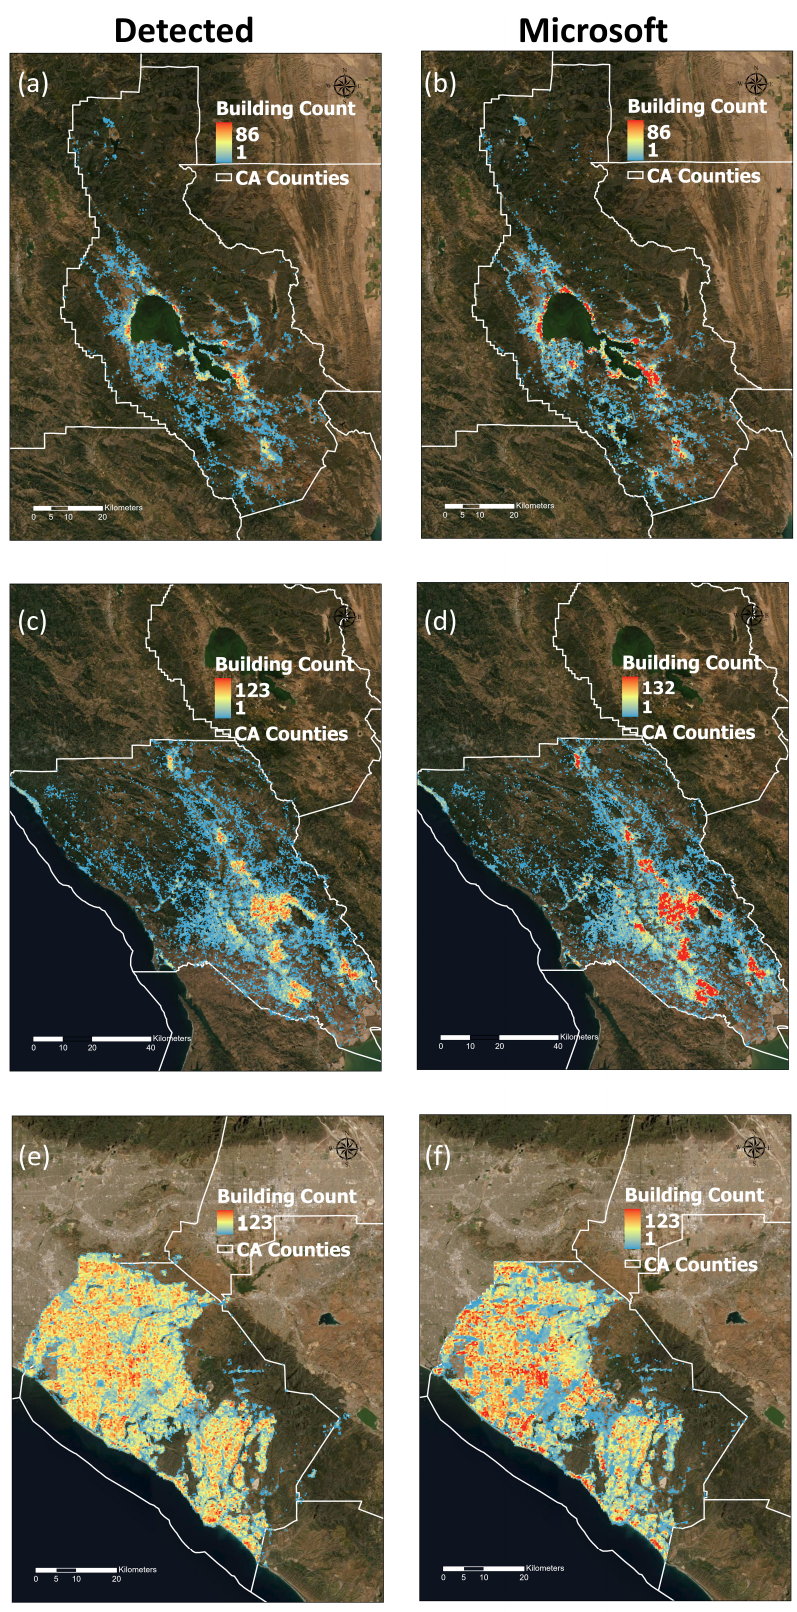
Figure 5. Comparison of building counts aggregated to 300 m resolution from individual building footprints in 2018 by this study ( left panel ) and Microsoft ( right panel ) in Lake ( a , b ), Sonoma ( c , d ), and Orange Counties ( e , f